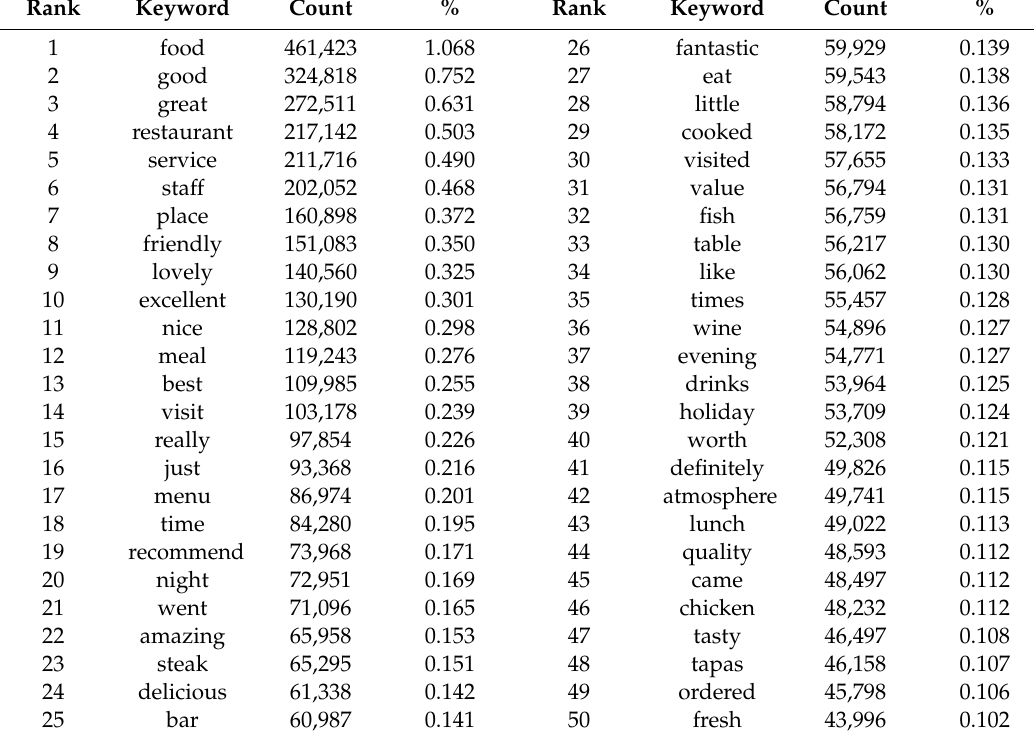
Table 4. Most frequent keywords. Count and percent out of total